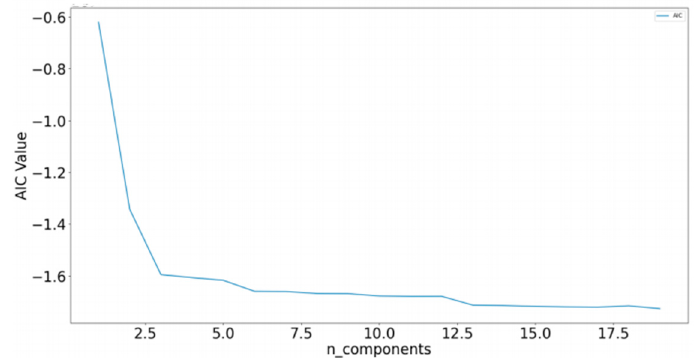
Figure 8. Change in AIC for different K values.